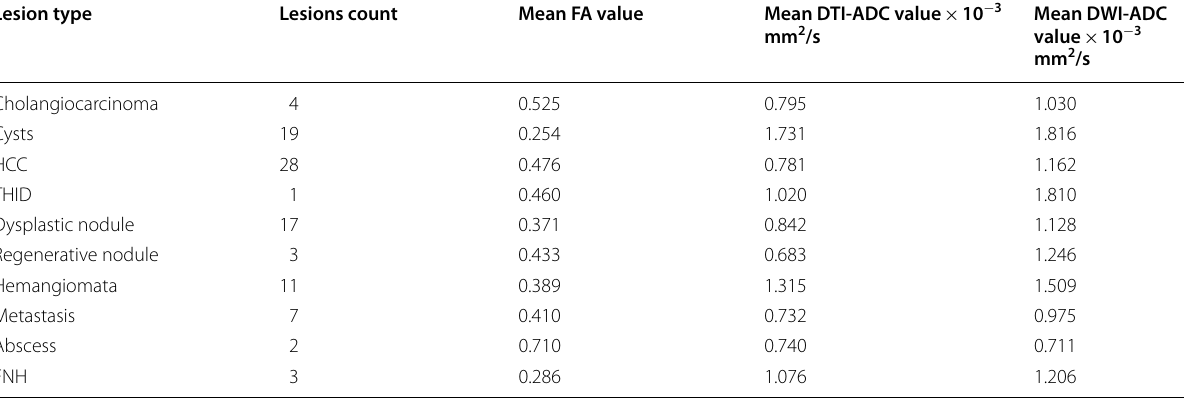
Table 4 Descriptive analysis of the FA, DTI-ADC and DWI -ADC values according to the lesions’ types Lesion type